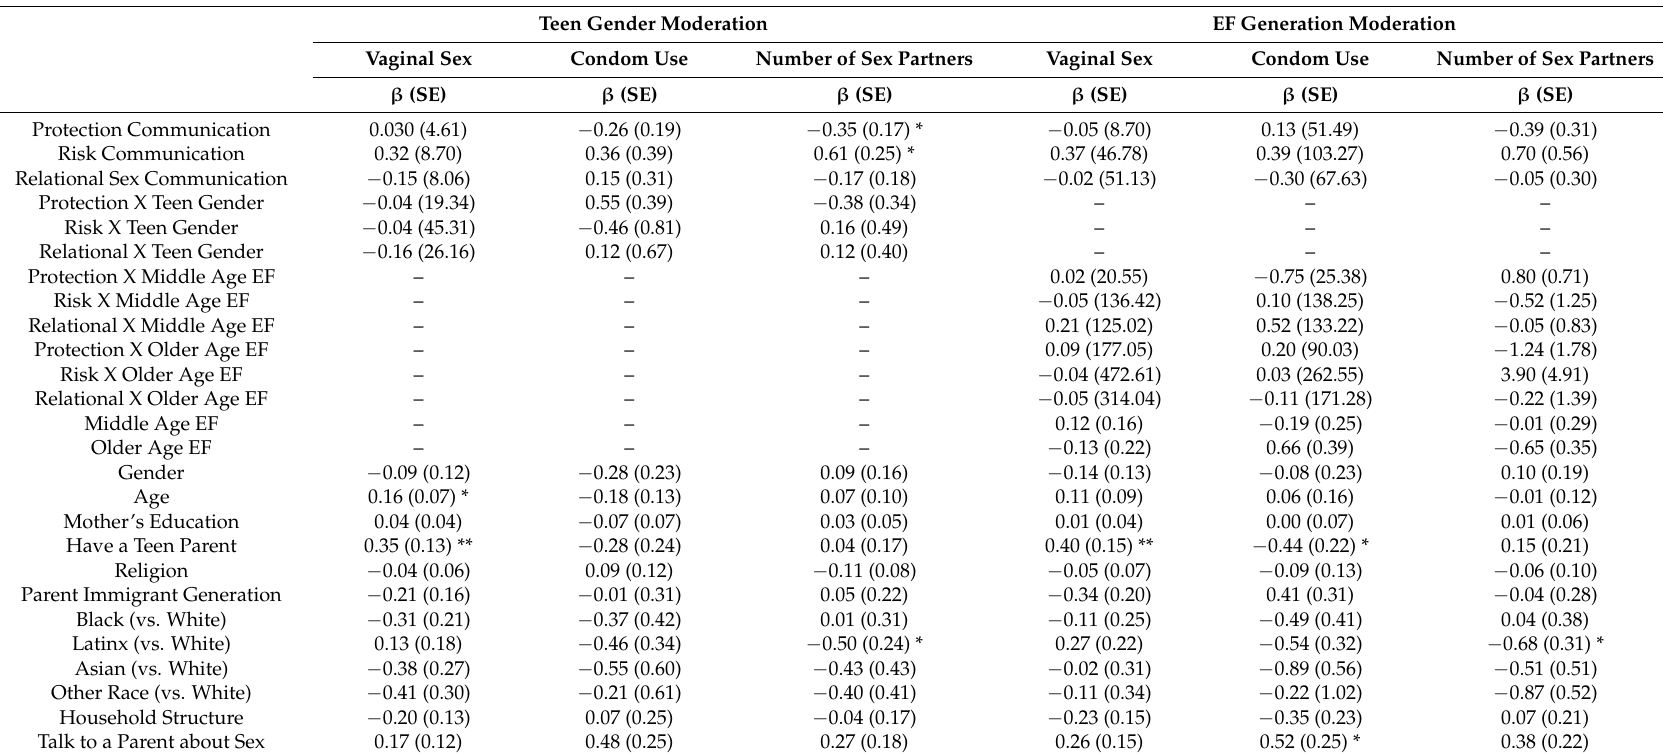
Table 2. Teen gender and extended family generation as moderators of the relationship between extended-family (EF) communication and teen sexual